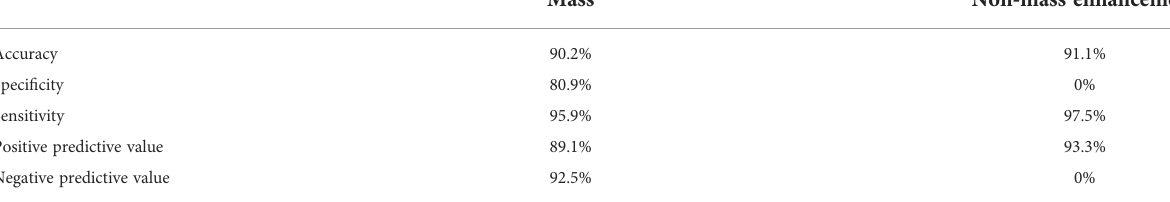
TABLE 4 Diagnostic Performances of the CNN model for mass and non-mass enhancement.